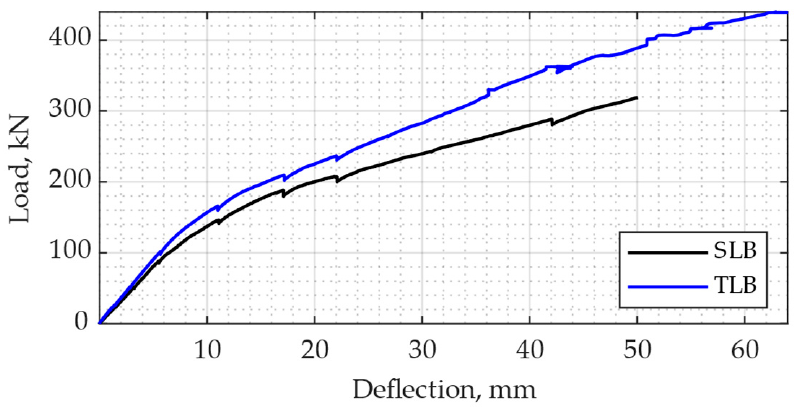
Figure 4. Load–mid-span deflection (LVDT 2) diagram.